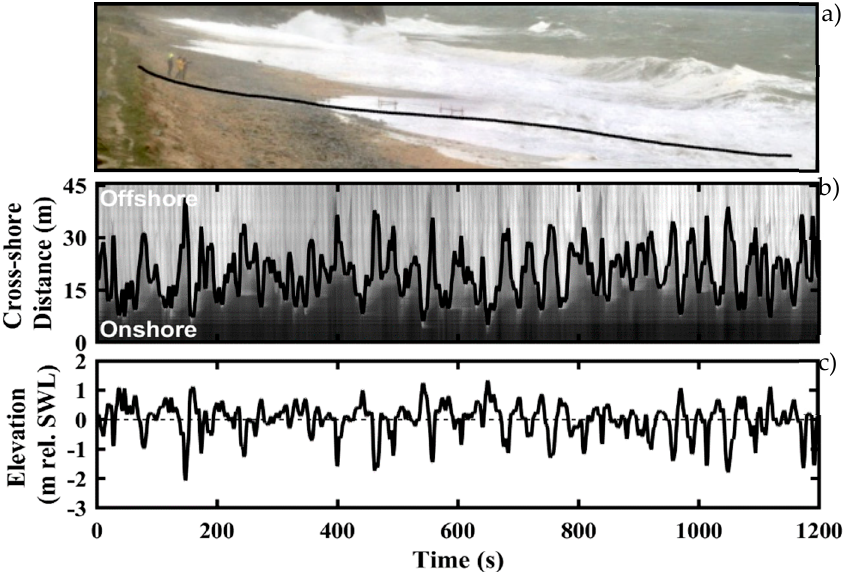
Figure 3. Video processing technique: example from 26 February 2018 from 3:30–3:50 p.m. at Beesands. ( a ) Analyzed profile to be extracted (black line); ( b ) pixel stack with shoreline detected and time series of horizontal swash (black line); ( c ) vertical swash time series relative to still water level (SWL).